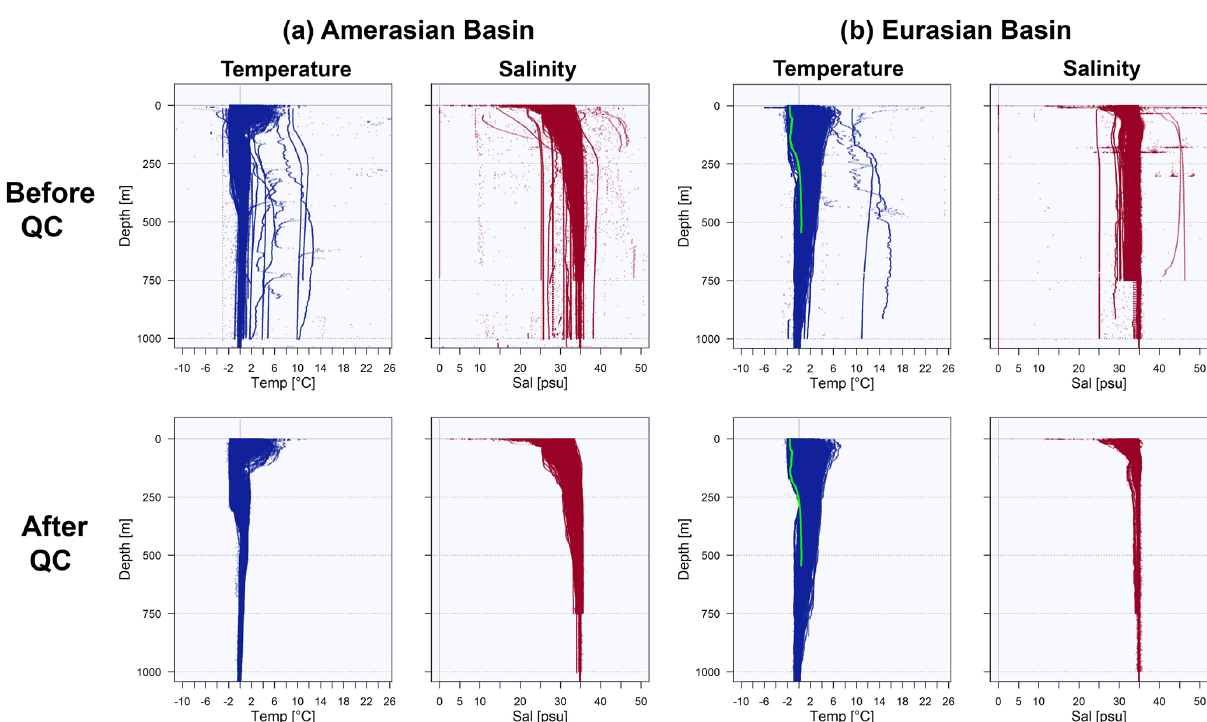
Figure 8. Temperature and Salinity from (a) approximately 37000 profiles measured in the Amerasian Basin (see Fig. 6) and (b) approxi- mately 17000 profiles measured in the Eurasian Basin before (upper panels) and after (lower panels) data validation and removal of outliers. The green line in the temperature profiles of (b) is the profile from Fig. 7 that failed the statistical